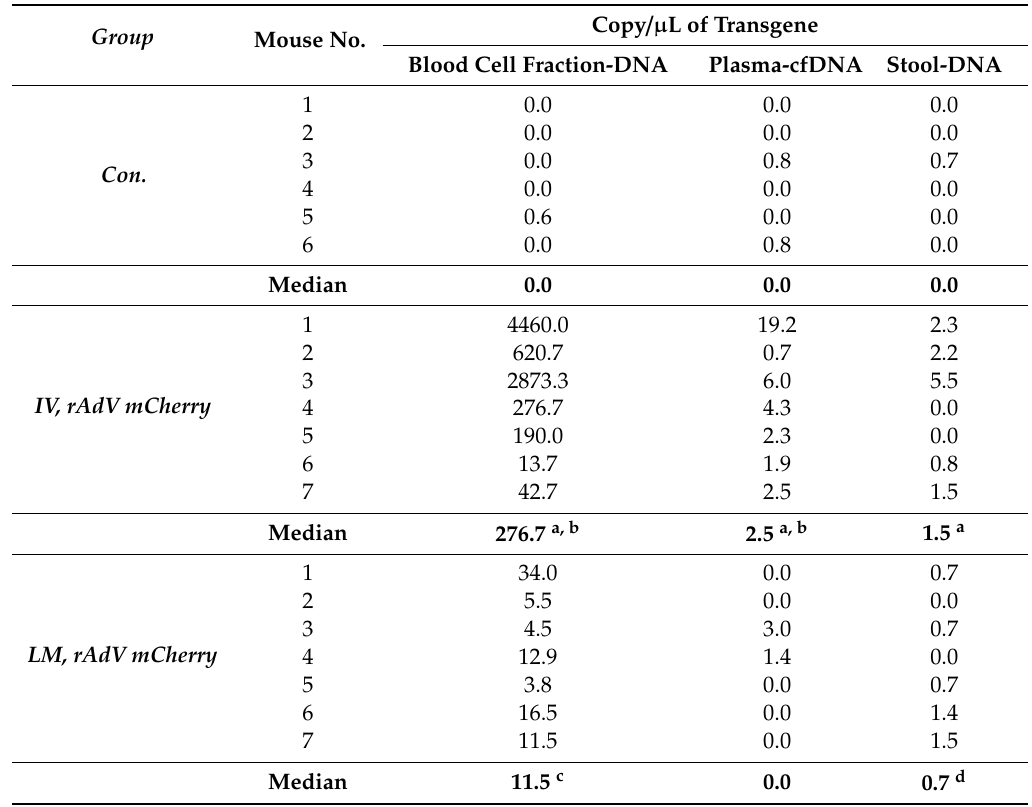
Table 4. Detection of transgene fragments from droplet digital PCR ddPCR. Transgene fragments were detected in blood cell fraction DNA in the IV group. IV means intravenous injection, and LM means local muscular injection of the rAdV vector in the tibialis anterior (TA) muscle. a: p < 0.01 vs. con. within same specimens. b: p < 0.05 vs. local injection within same specimens. c: p < 0.05 vs. con. within same specimens. d: p = 0.089 vs. con. within the same specimens.